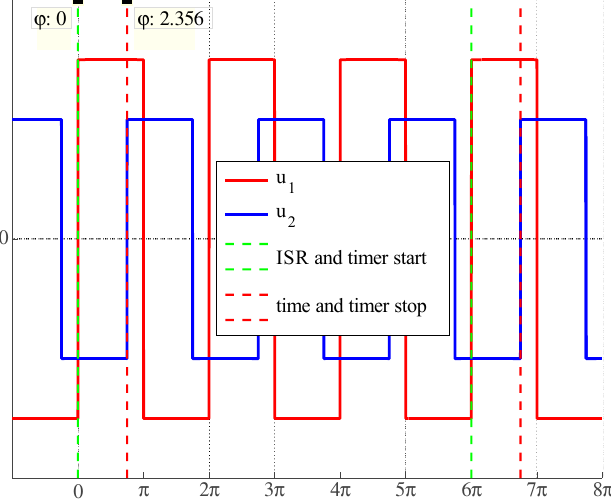
Figure 5. Idealized waveforms and important signals.